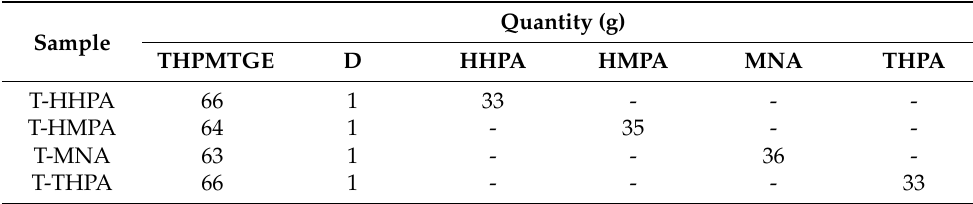
Table 1. Component amounts for 100 g of thermosetting